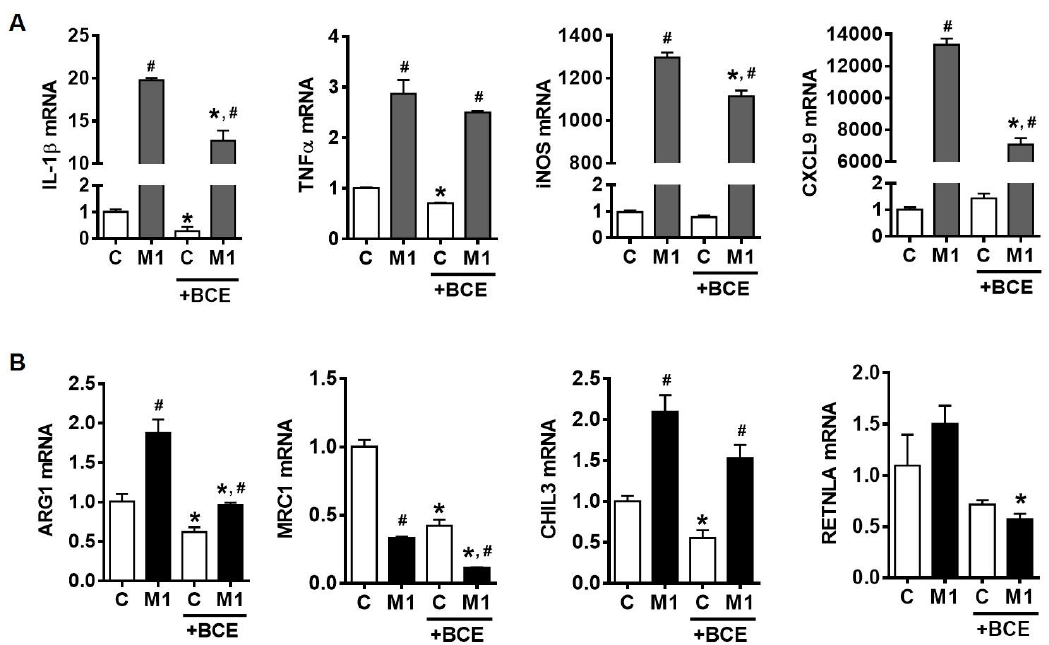
Figure 2. Expression of M1 and M2 marker genes in mouse bone marrow-derived macrophages (BMDM). BMDM were polarized to M1 using interferon γ (IFNγ) and tumor necrosis factor α (TNFα) (10 ng/mL each) with or without 50 µg/mL of blackcurrant extract (BCE) for 24 h. ( A ) The expression of M1 markers. ( B ) The expression of M2 markers. Data are shown as mean ± SEM. *, p < 0.05 vs. respective no BCE control. #, p < 0.05 vs. control within no or BCE treatment.